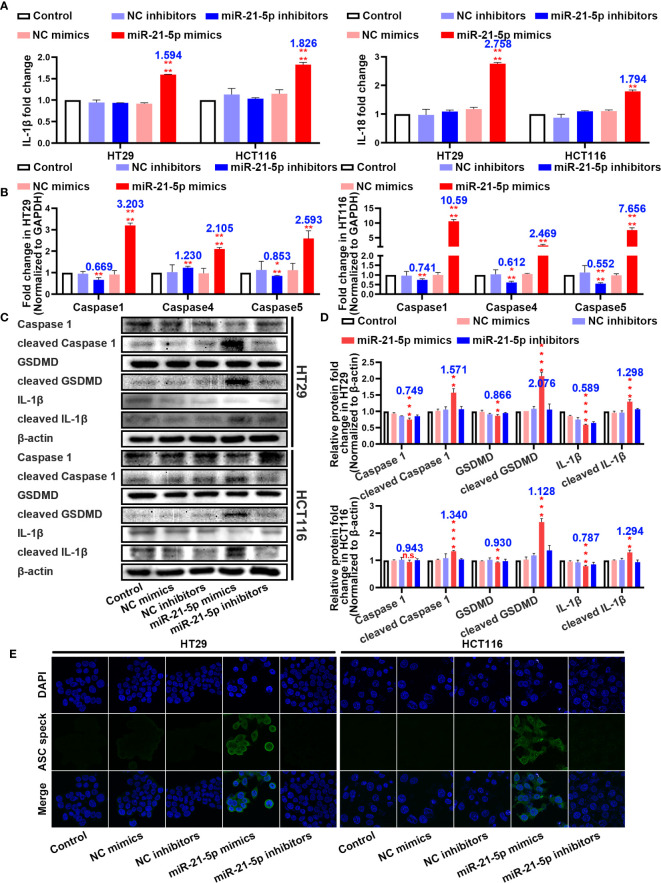
Pathway evidence of miR-21-5p induced pyroptosis of colorectal cancer (CRC) cells. (A) ELISA assay tested the IL-1β and IL-18 which released in HT29 and HCT116 cell culture mediums by the transfection of miR-21-5p mimics and inhibitors. (B) Pyroptosis-associated mRNA levels in HT29 and HCT116 cells after miR-21-5p mimics and inhibitors transfection as determined by qRT-PCR. (C, D) Expression of Pyroptosis-associated proteins in HT29 and HCT116 cells after miR-21-5p mimics and inhibitors transfection as determined by western blot analysis. (E) Immunofluorescence staining of ASC specks expression in miR-21-5p mimics and inhibitors transfected HT29 and HCT116 cells. The bars and error bars indicate the mean ± SD. n.s.p > 0.05, **p < 0.01, ***p < 0.005, ****p < 0.001.